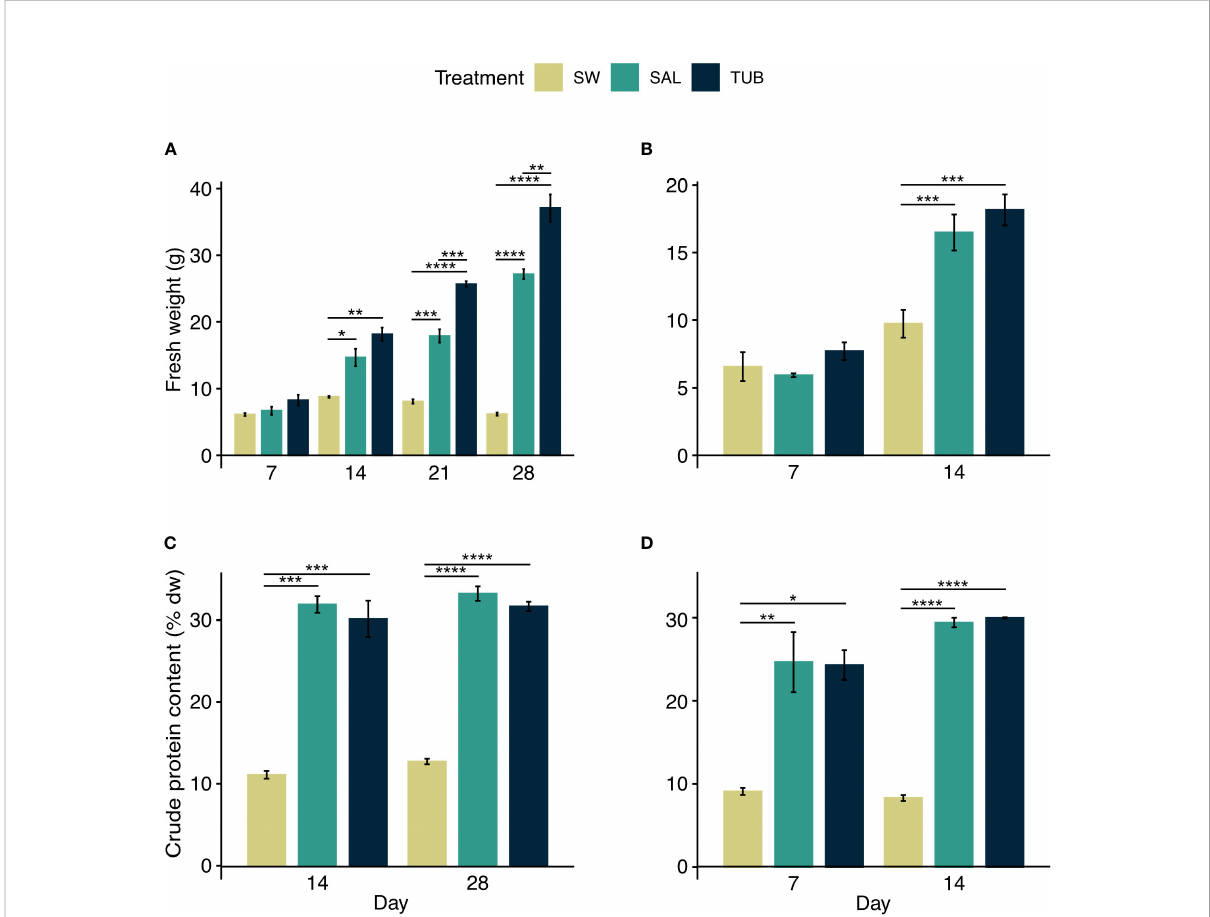
FIGURE 1 Fresh weight (g) of Ulva fenestrata cultivated in seawater control (SW) and the two herring production process waters salt brine (SAL) and tub water (TUB) during the (A) fi rst experiment, and (B) second experiment, as well as their crude protein content (% dw) in the (C) fi rst experiment, and (D) second experiment (mean ± SEM, n = 3). Signi fi cant differences from the pairwise paired t-test are denoted by